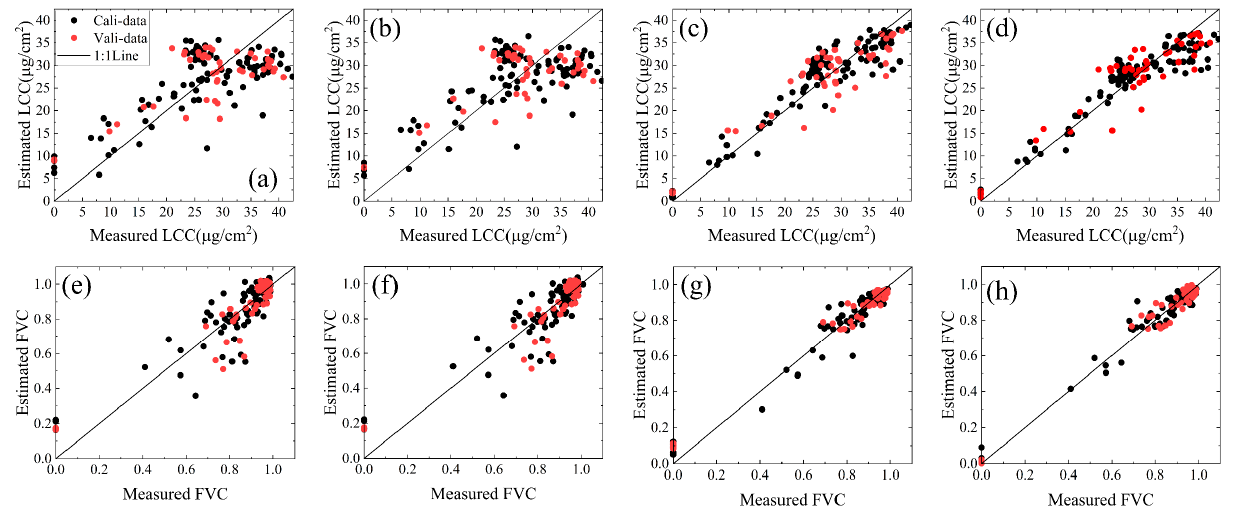
Figure 8. Relationship between predicted and measured soybean LCC and FVC: ( a ) PLSR-LCC; ( b ) MSR-LCC; ( c ) RF-LCC; ( d ) MSR-LCC; ( e ) PLSR-FVC; ( f ) MSR-FVC; ( g ) RF-FVC; ( h ) GS-FVC.